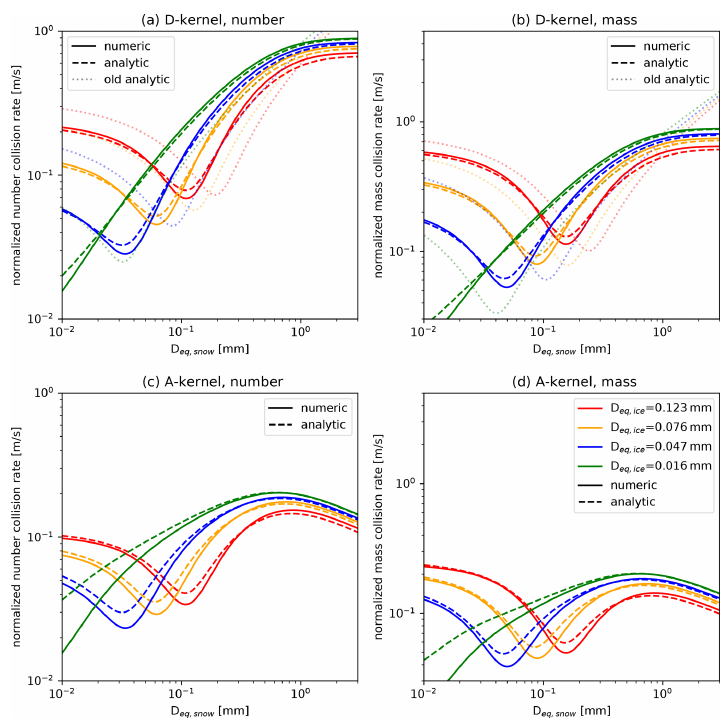
Figure B2. Same as Fig. B1 but with µ eq = 8 (Eq. 7), which is equal to µ m = 2 (Eq. 5) for snow.